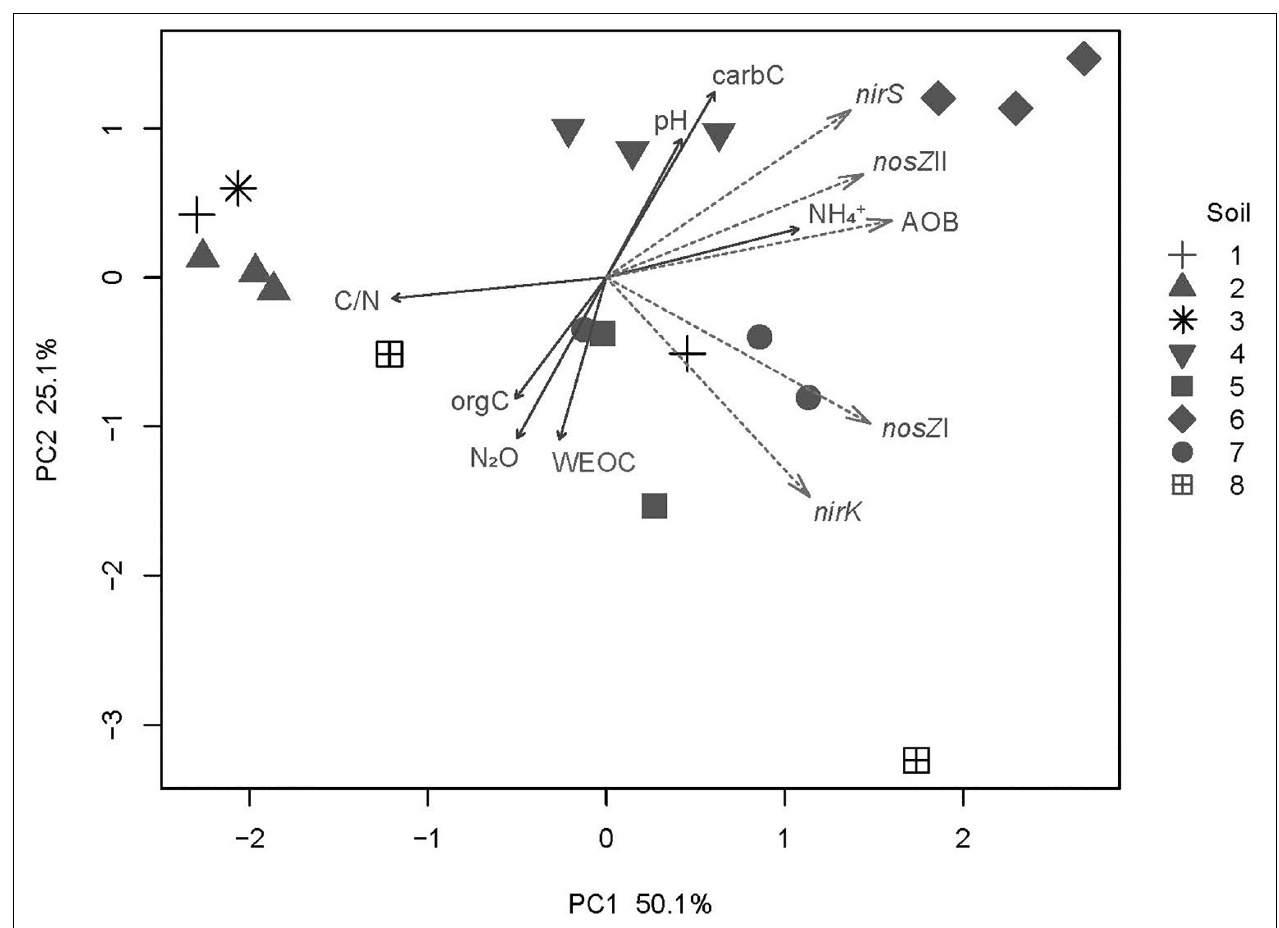
FIGURE 4 | Nitrogen cycling assemblages in topsoils. Principal component analysis of the respective ratios between abundances of nirS , nirK , nosZ I, nosZ II, and bacterial amoA and 16S rRNA gene abundances in the eight soils at a water suction head of 0.5 m. Solid arrows show direction of soil factors that correlate significantly ( p < 0.05), with the ordination and arrow length proportional to the strength of correlation. Dashed arrows indicate increasing relative abundance of each functional group in relation to soil sample. The nitrous oxide (N 2 O) values represent fluxes at near water-saturated conditions, WEOC, water-extractable organic C; carbC, carbonate carbon; orgC, organic